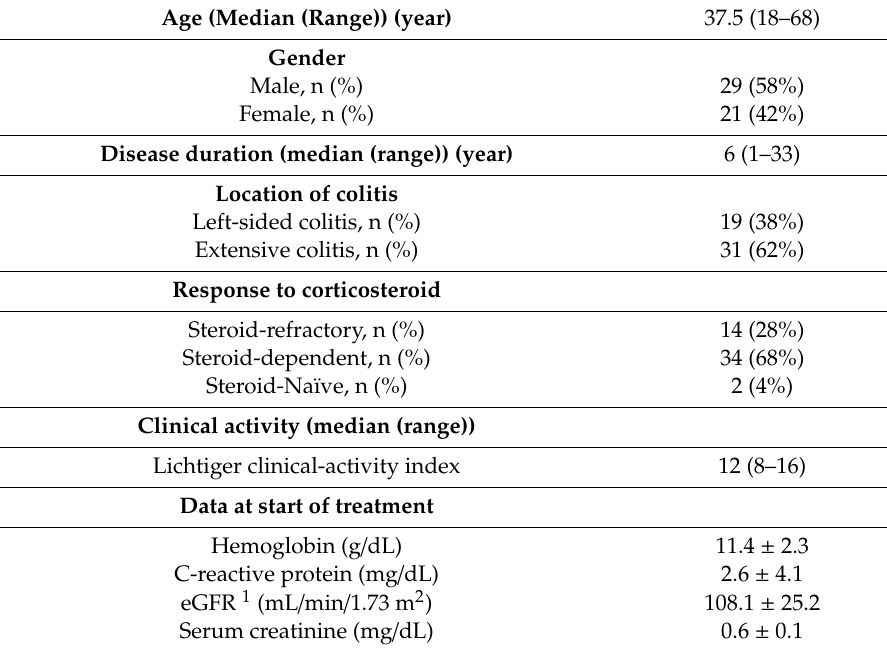
Table 1. Patient